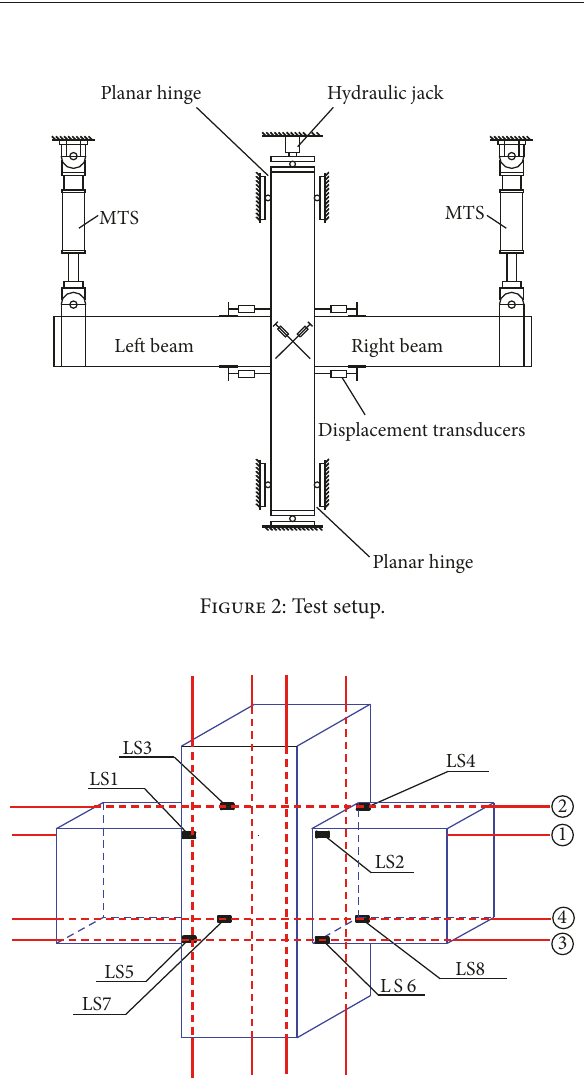
Figure 3: Configuration of strain